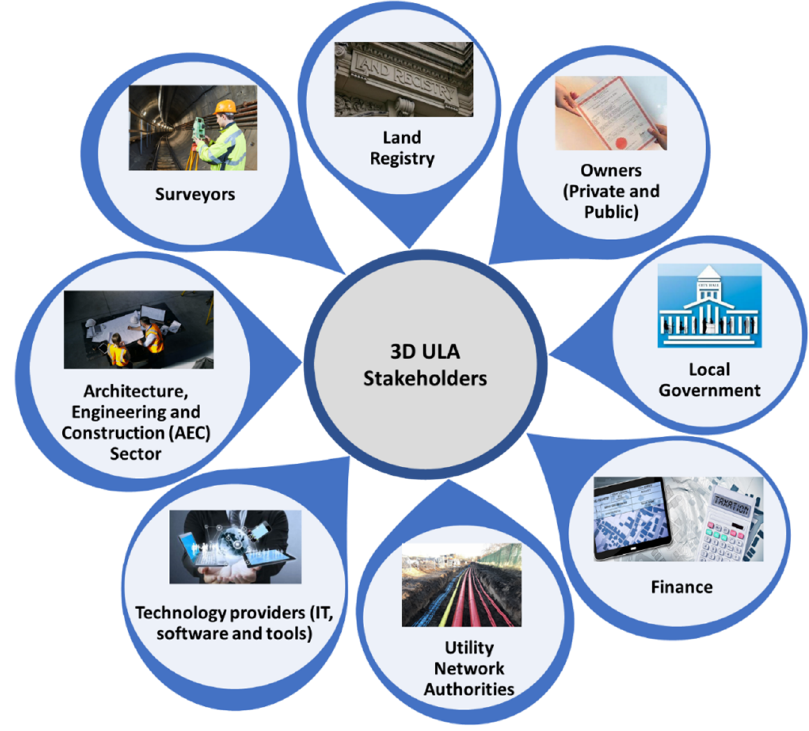
Figure 4. The important stakeholders involved in a ULA